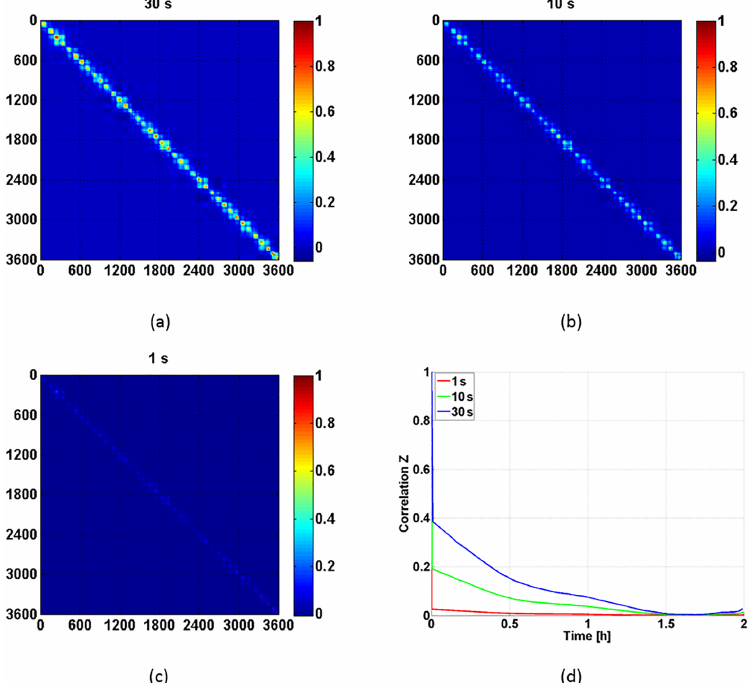
Figure 16. Correlation matrix for 30h time span in Z -component obtained with a (a) 30s, (b) 10s and (c) 1s data rate. The identical epochs (30s interval) are extracted from the respective correlation matrix. Panel (d) shows the mean correlation over